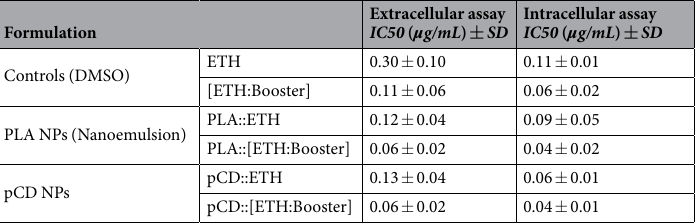
infection, the bacterial load for the control group increased, reaching 10 9 CFUs (in comparison to one week treatment, 10 7 CFUs) (Fig. 6a,b). Lungs from the mice that were treated with 6 doses of the [ETH:Booster] pCD NPs had a mean value of 5 × 10 5 CFUs, which indicates a dramatic (3-logs) improvement in the efficacy of the formulation compared to three doses only. Corroborating with the massive decrease in the mycobacterial load, the lungs that received [ETH:Booster] pCD NPs displayed much less cell infiltrates than control animals (Fig. 6c). Moreover, the reduction of bacterial load in the lungs was much higher when ETH was co-encapsulated with the Booster (p < 0.001) than when ETH was administered alone (p < 0.1) (Fig. 6b). Noteworthy, when the for- mulation containing [ETH:Booster] was given by oral gavage using the same regimen (i.e. 6 doses every 2 days),